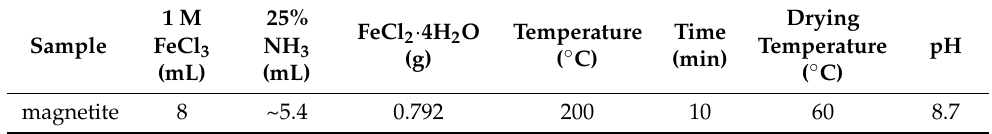
Table 2. Experimental conditions for magnetite NPs